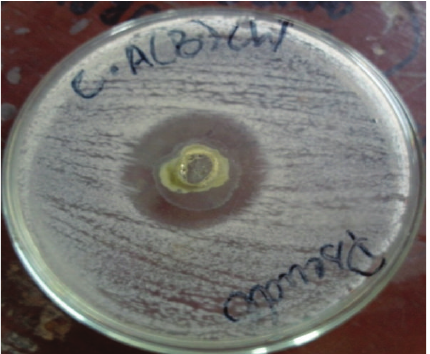
Figure 26: Zone of inhibition of chloroform extract of bark of C. ambrosioides L. against P. aeruginosa